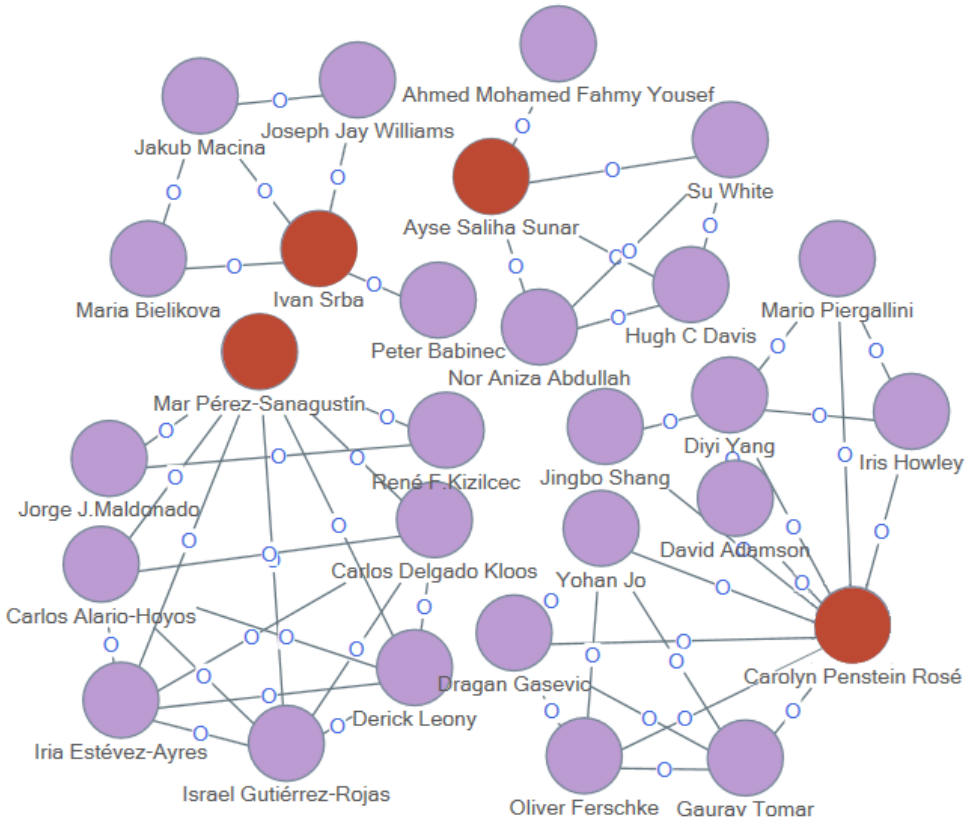
Figure 2. Network diagram of authors who are linked with other groups of authors. Red nodes indicate authors who have publications with more than one